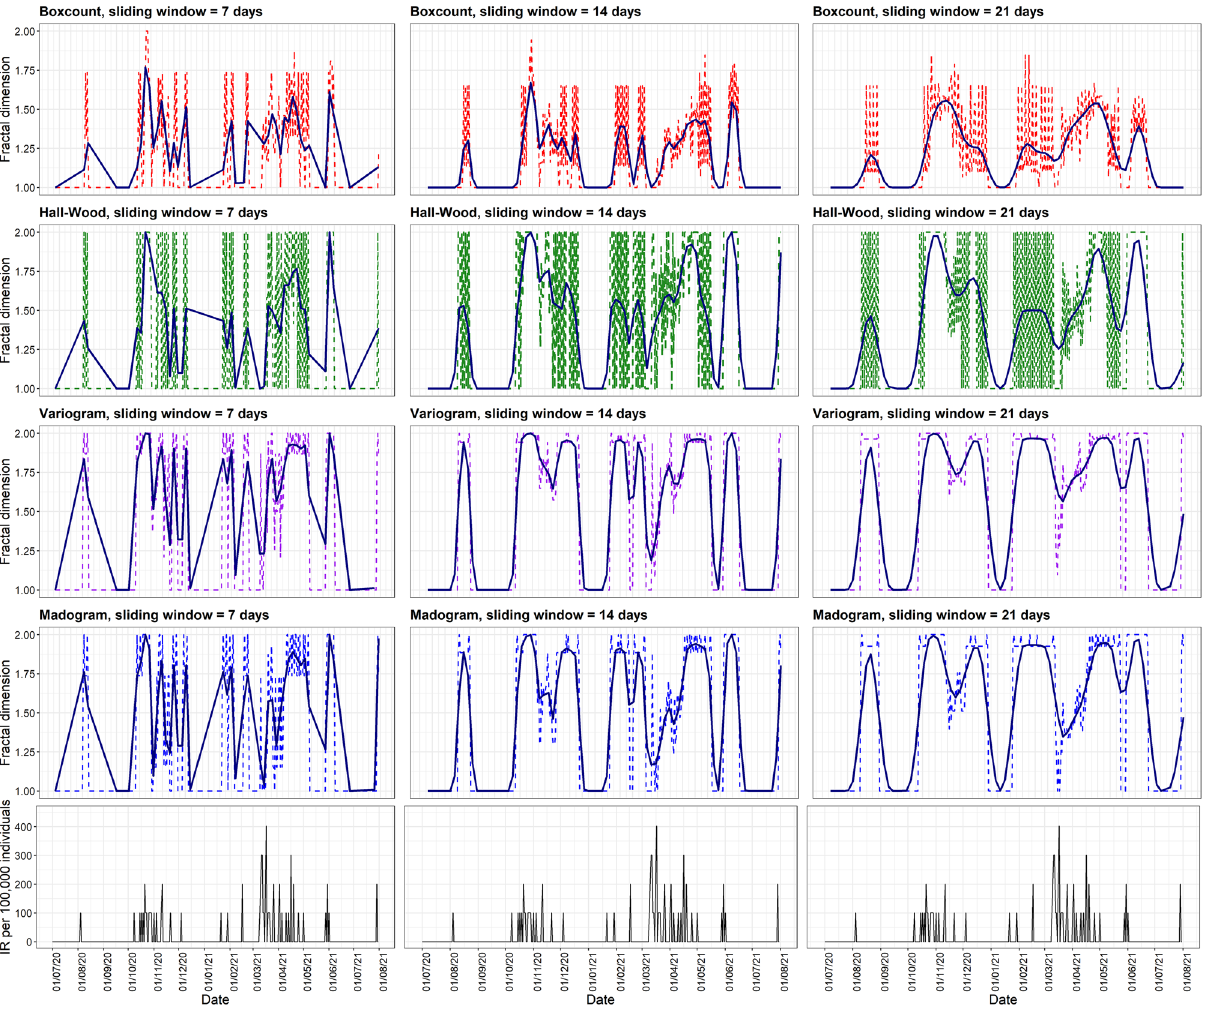
Figure 3. Local fractal dimension of COVID-19 incidence rate in Prinshoeveland , Antwerp. The raw fractal dimension value is depicted by the dashed line. Dark blue solid lines correspond to LOESS regression of the local fractal